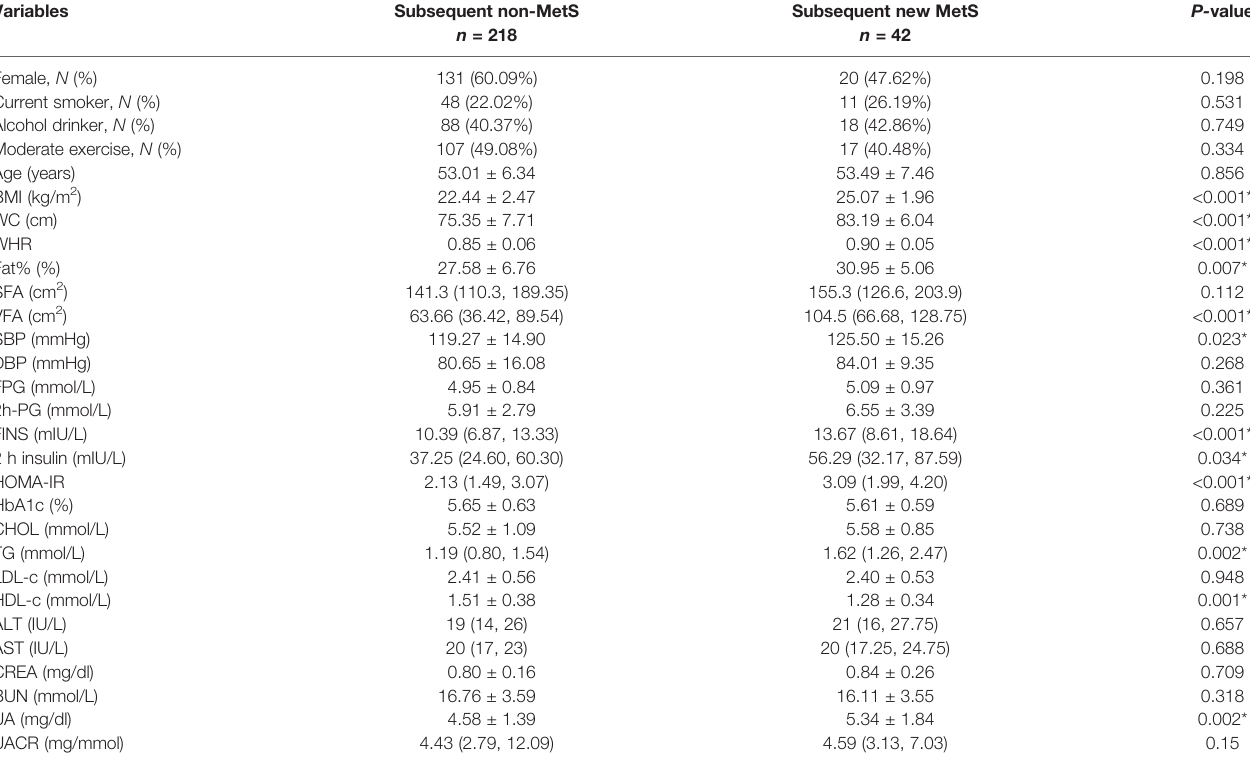
TABLE 6 | Comparison of the baseline of general clinical characteristics and biochemical indicators between 42 subsequent new MetS and 218 subsequent non-MetS. Variables